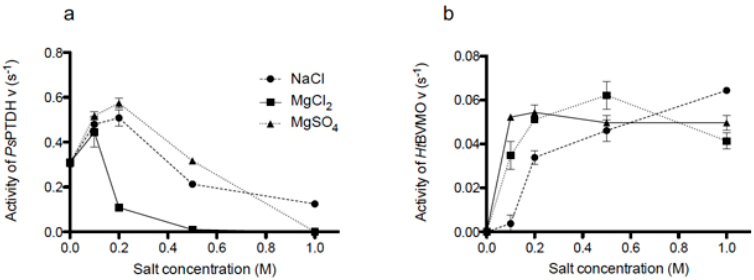
Figure 6. Activity of Ps PTDH. ( a ) and Ht BVMO ( b ) in the presence of 0–1.0 M NaCl, MgSO 4 and MgCl 2